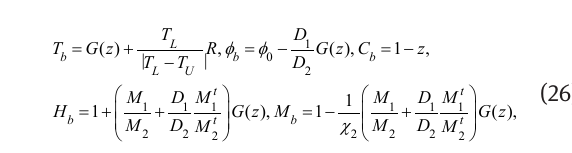
Figure 2 represents the base flow profiles of M . The figure is plotted for two different configurations, b namely, when the layer is heated from below and when the layer is heated from above